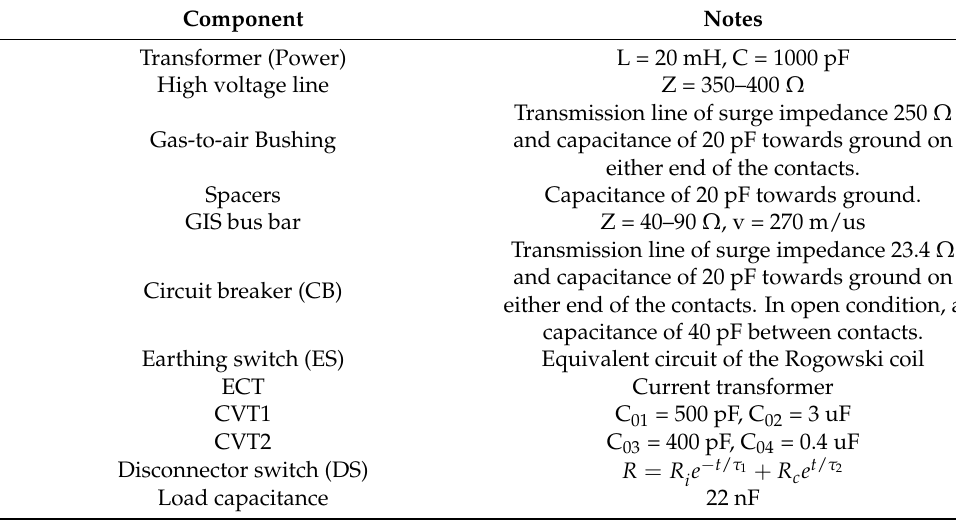
Table 2. Equivalent circuits and value of circuit